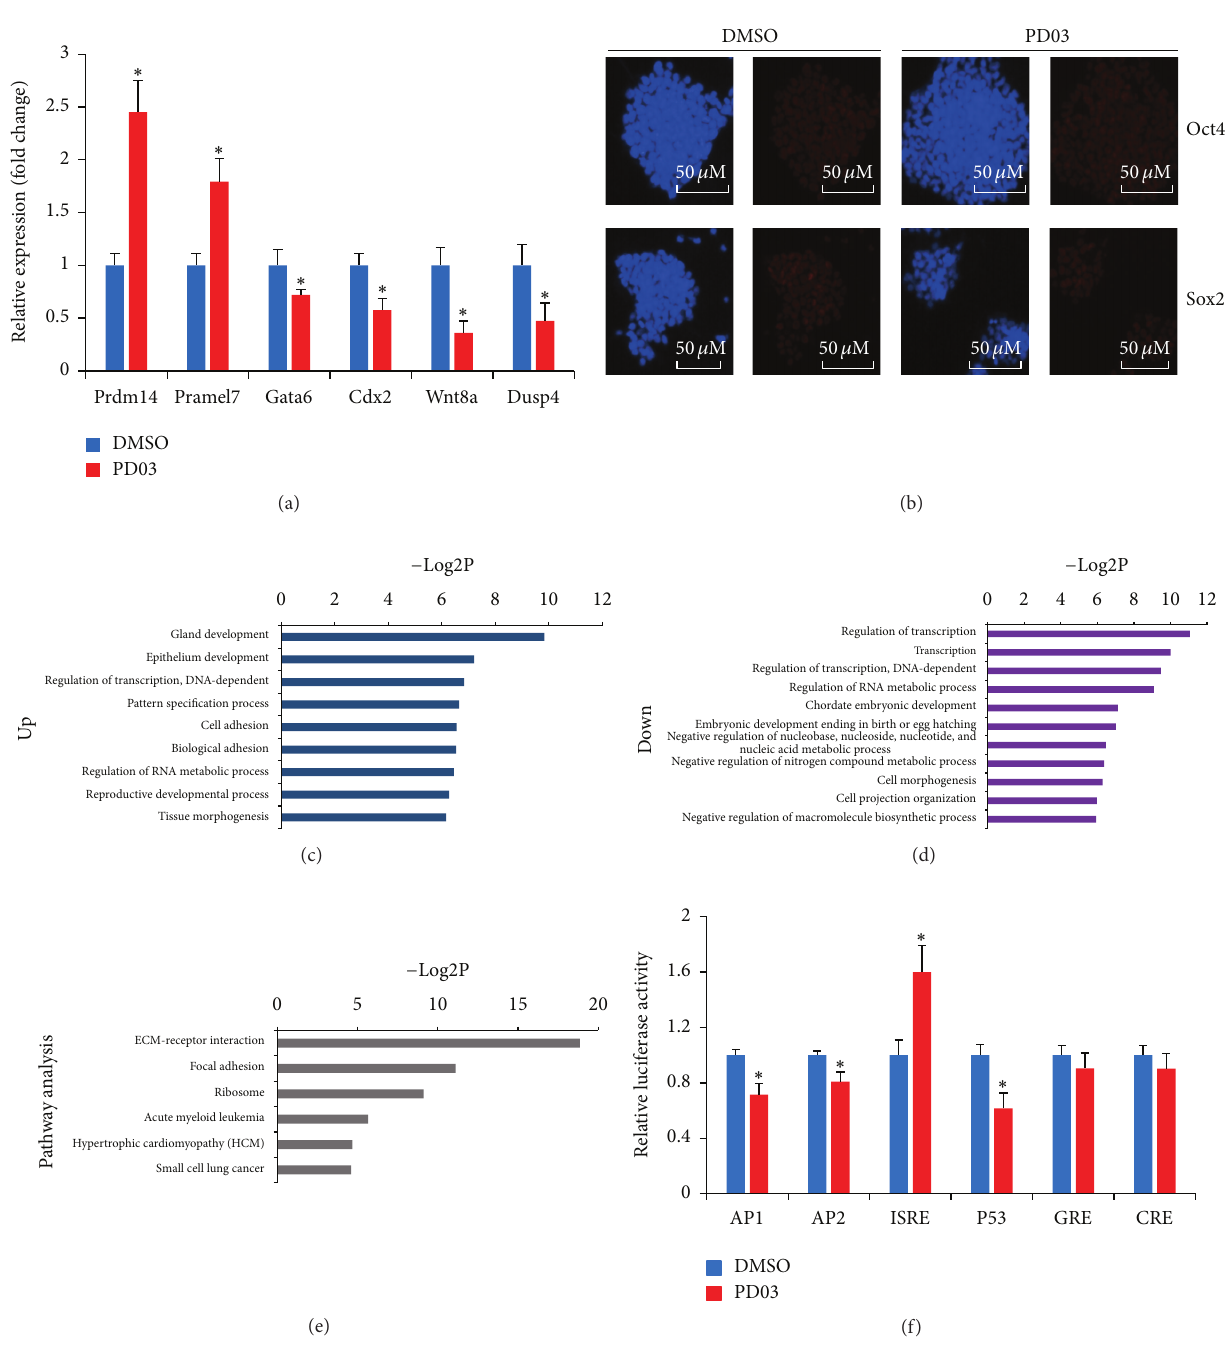
Figure 2: Transcripts involved in self-renewal and differentiation were regulated by PD. (a) qPCR validation of the microarray data. Cells were treated with 1 𝜇 M PD or equal volume of DMSO for 24 h. The expression levels of Prdm14, pramle7, Gata6, Cdx2, Wnt8a, and Dusp4 were detected by RT-qPCR. Error bars indicate mean ± SD of three independent experiments, ∗ 𝑝 < 0.05 compared with controls. (b) The expression of Oct4 and Sox2. Cells were treated with 1 𝜇 M PD or equal volume of DMSO for 24 h. Immunofluorescence staining assay was used for analysis of the expression level of Oct4 and Sox2. Nuclei were stained with DAPI; scale bar = 50 𝜇 m. (c and d) GO annotation of PD- regulated genes. GO term enrichment of the “biological process” category of PD-regulated genes. GO terms ranked according to the − Log2P of upregulated genes (count > 10) (c) or downregulated genes (d) were plotted. (e) KEGG pathway analysis of differentially expressed genes. KEGG pathway analysis of differentially expressed genes in PD-treated J1 mESCs. This result was ranked according to the − Log2P of